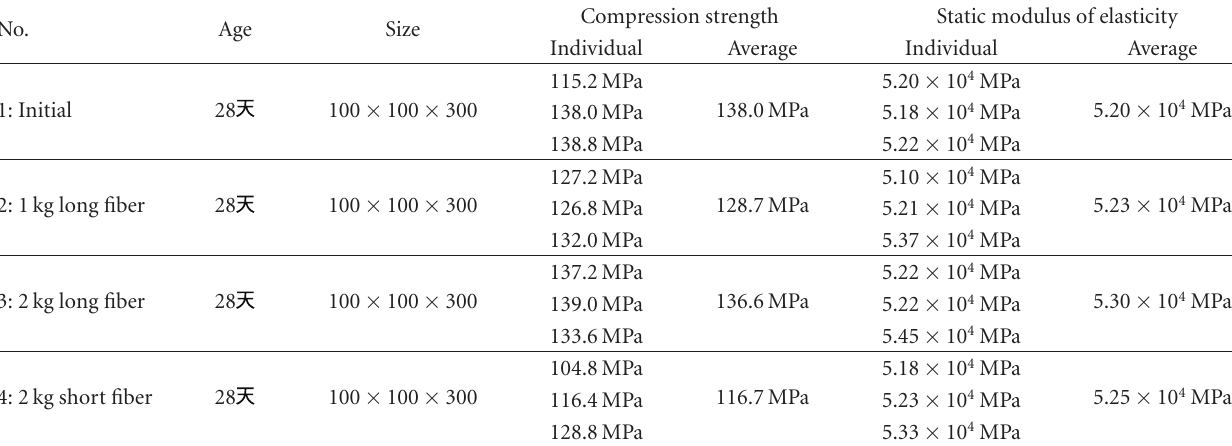
Table 3: Results of compressive strength and static modulus of elasticity of prism specimens.